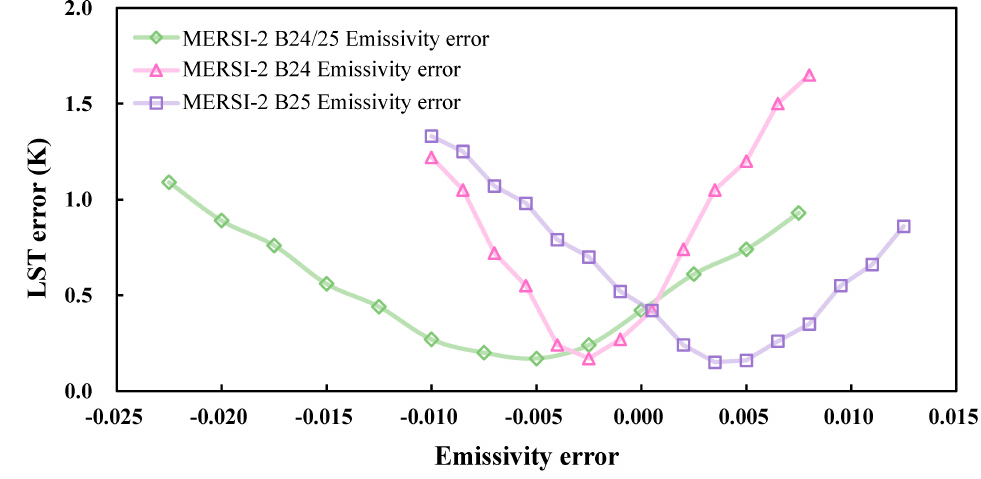
Figure 18. LST error caused by emissivity error.